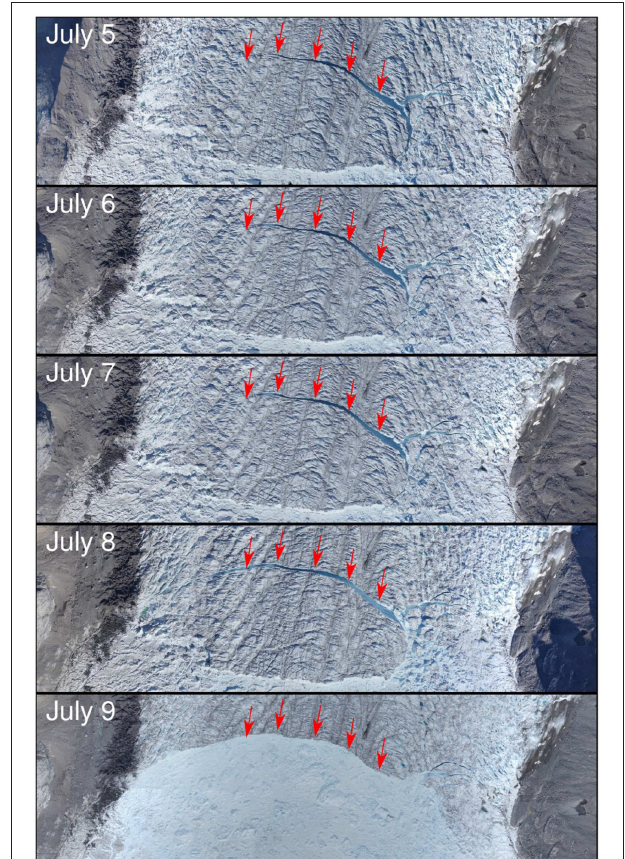
FIGURE 8 | Ortho-images of the front of Melville glacier before (July 5, 6, 7, 8) and after (July 9) the separation of a major tabular iceberg. The red arrows show the path taken by the crack as observed on July 6 and 7. The substantial extension of the crack on July 8 suggests that it propagated step-wise before to